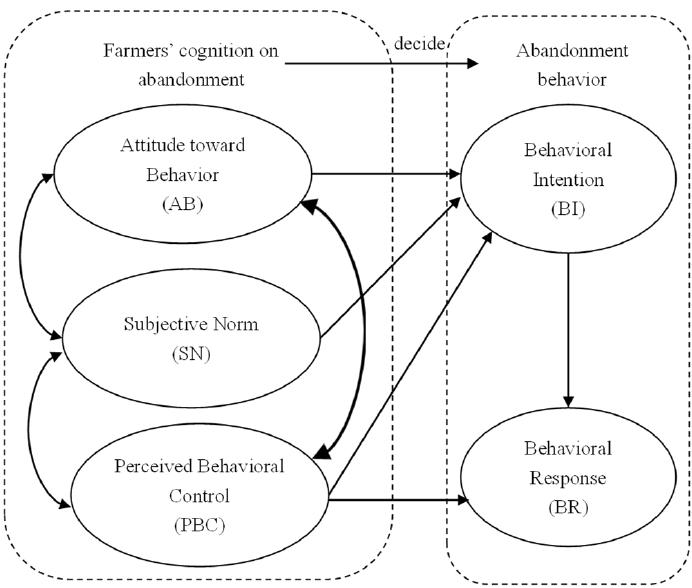
Figure 1. Decision model of farmers’ abandonment behavior, based on the TPB.